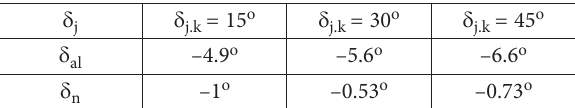
Table 1. Required trim angles δ al and δ